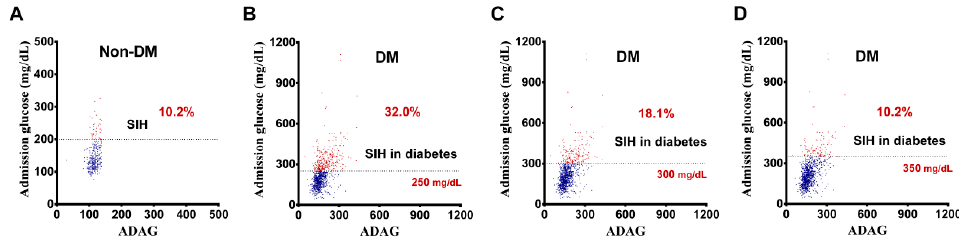
Figure 3. ( A ) The percentage of patients with SIH in non ‐ DM and DM groups, based on defined glucose levels set at ( B ) 250 mg/dL; ( C ) 300 mg/dL; and ( D ) 350 mg/dL.